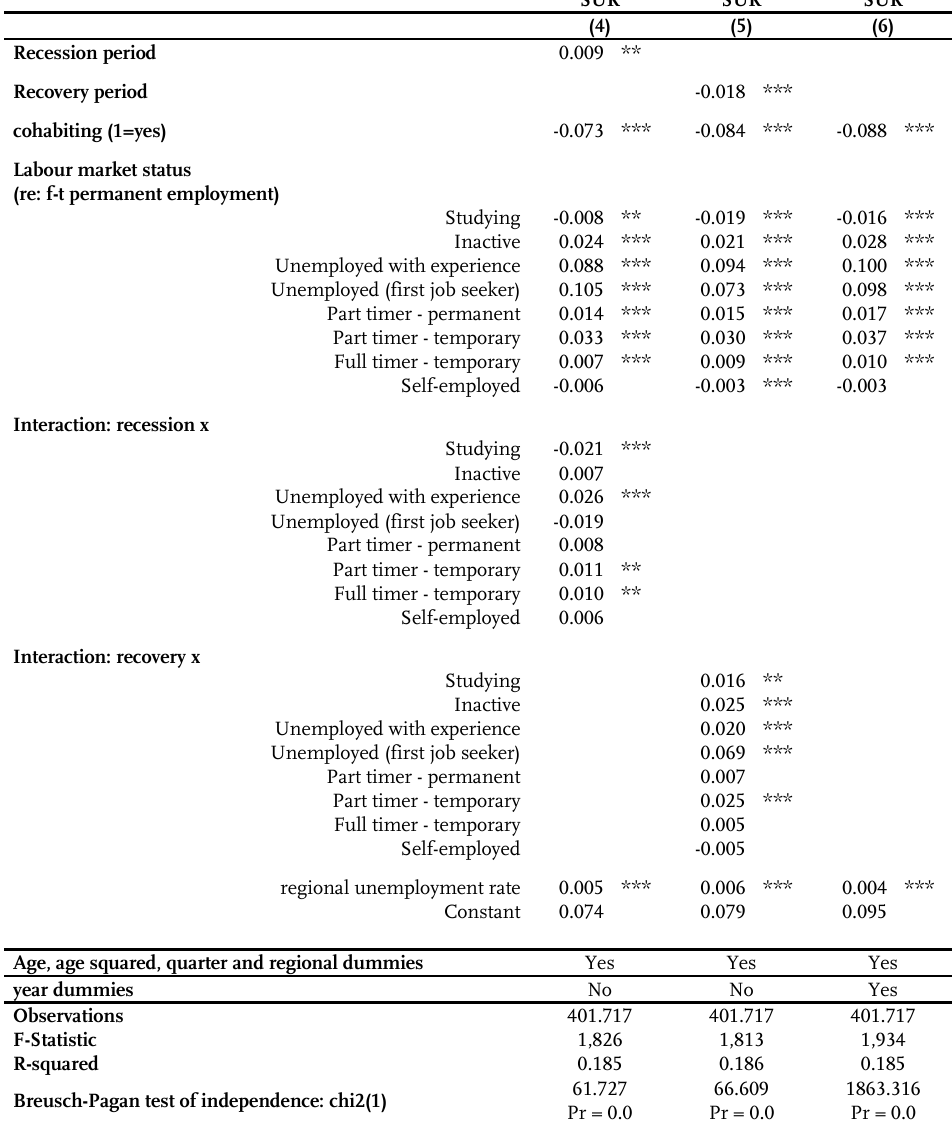
Table 4a: Seemingly unrelated regression results on household employment deprivation levels for females between 26-34 years of age. Spain. 2005-2017 SUR